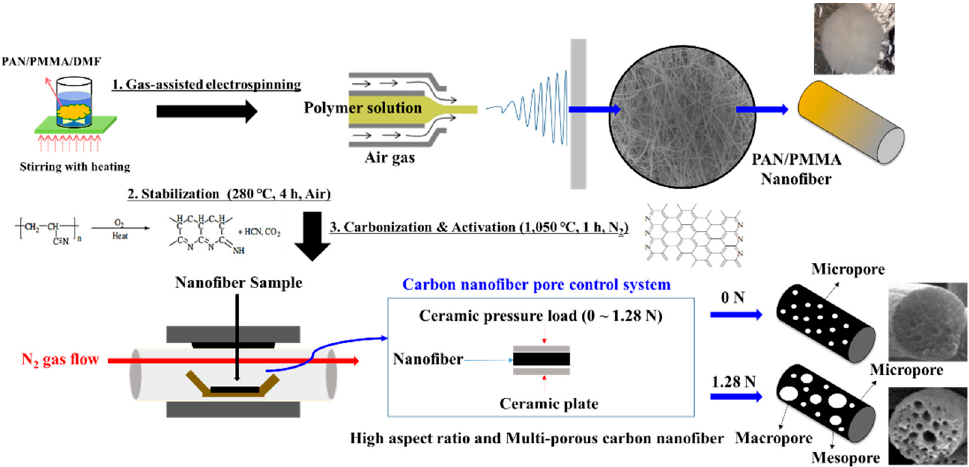
Figure 1. The schematic and photo images of multi-porous carbon nanofibers via ceramic plate load control.